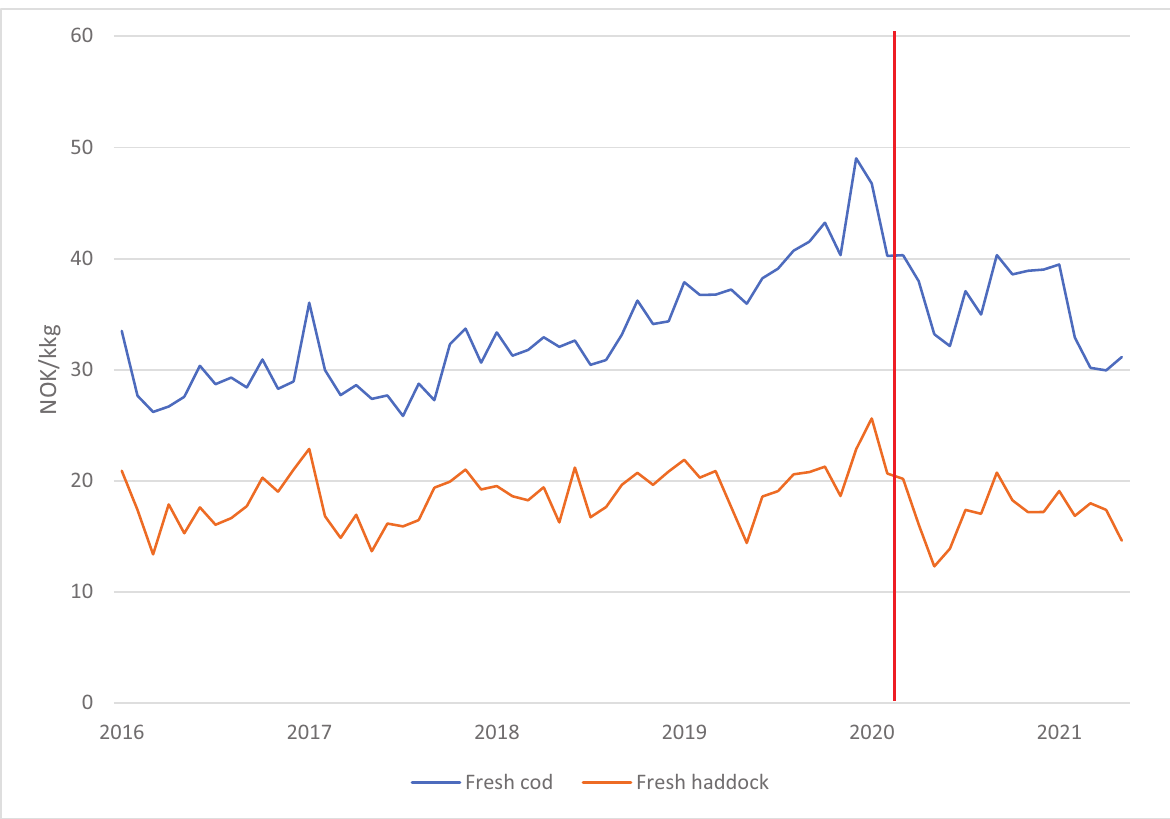
Fig. 5. Export prices for fresh whole cod and